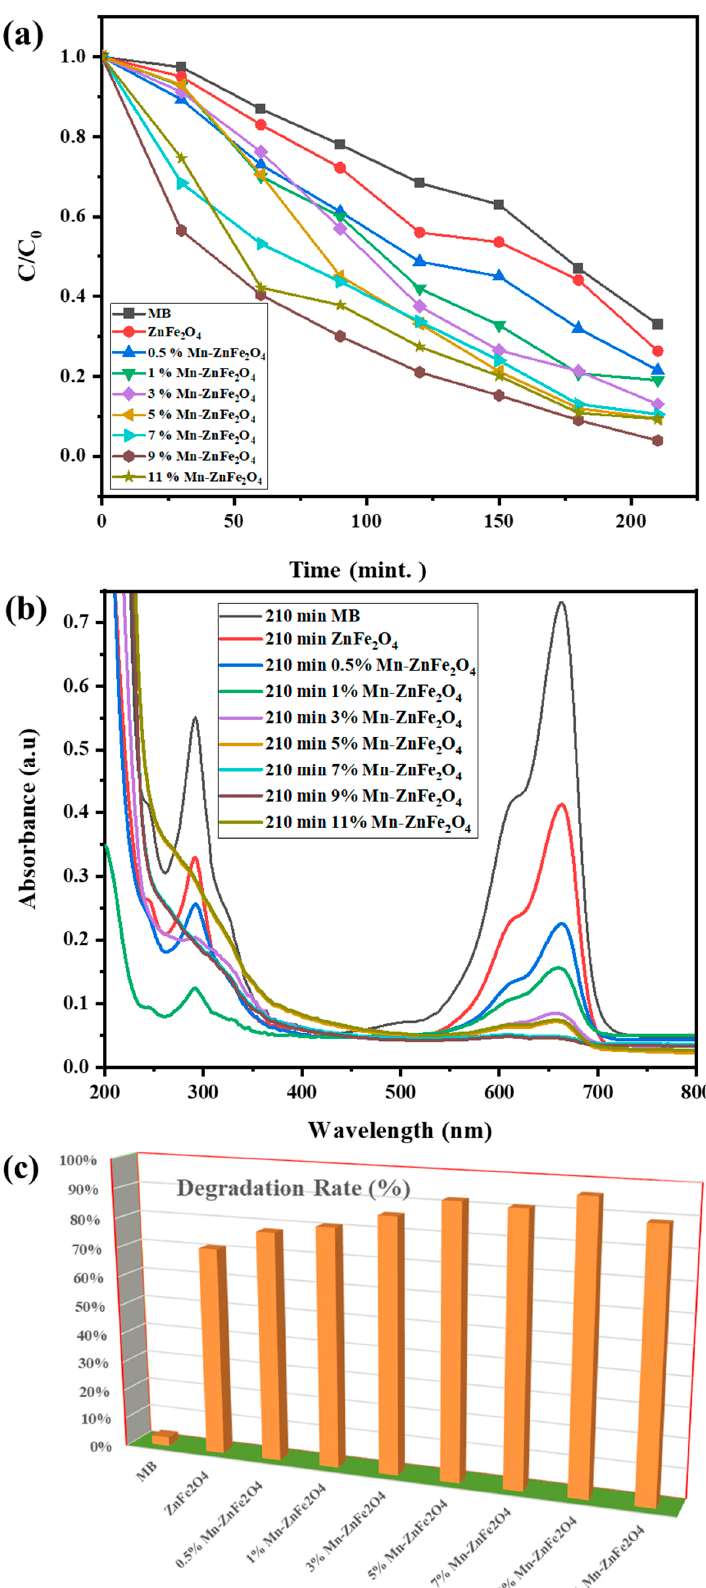
Figure 4. Degradation rate ( a ), degradation contours ( b ), and % degradation of MB ( c ) by Mn- ZnFe 2 O 4 NPs.